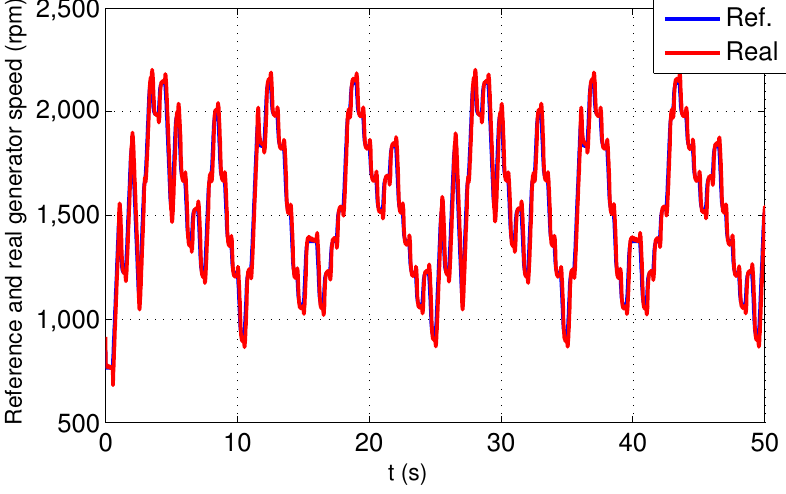
Figure 10. Reference and real rotor speed for the wind profile of Figure